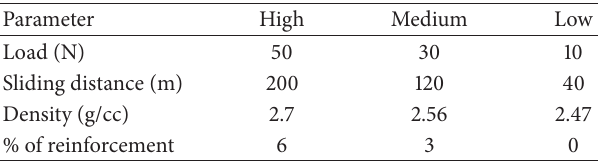
Table 1: Various parameters and their levels in pin-on-disc